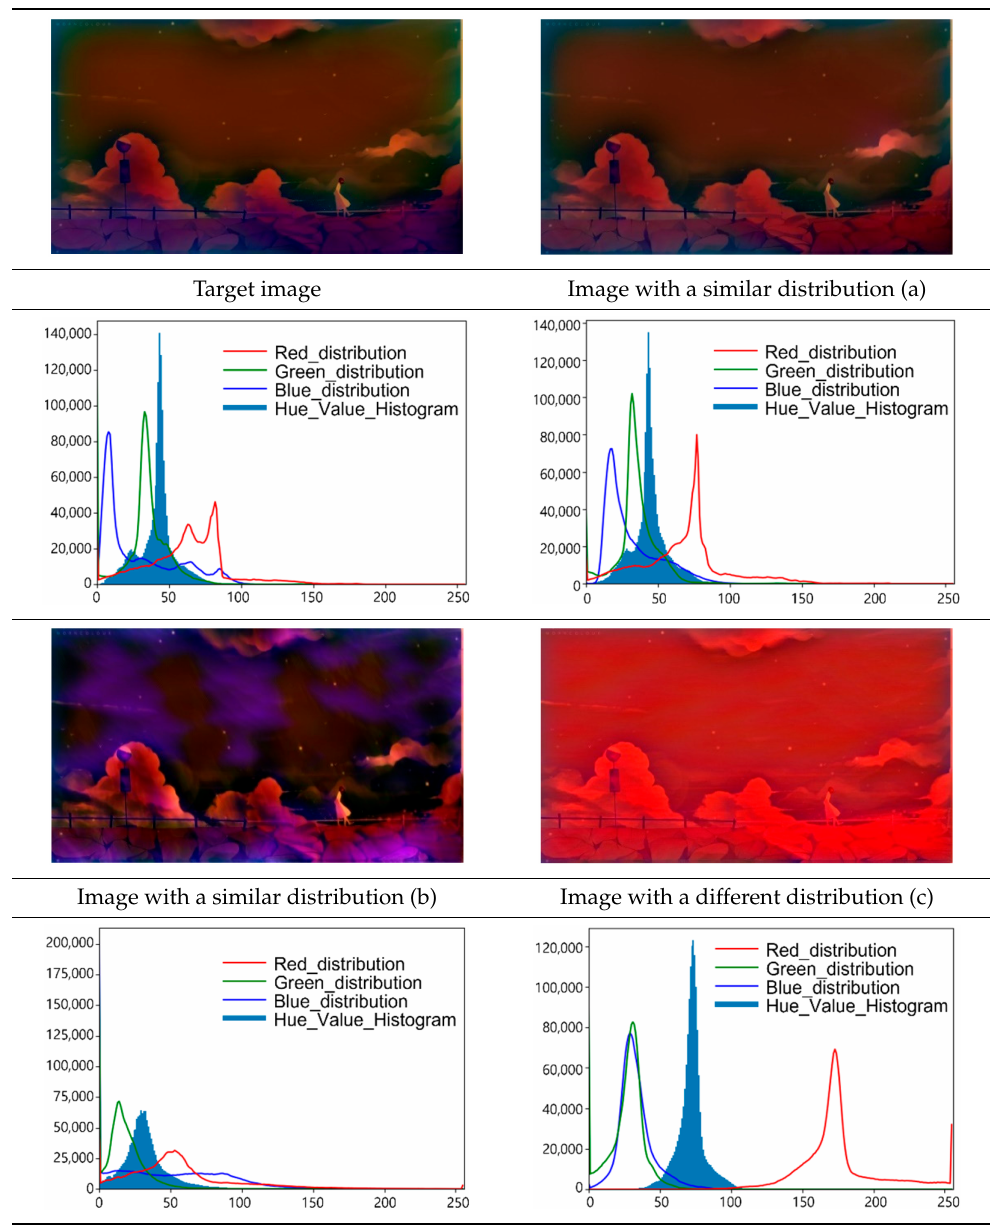
Table 6. Results of histogram graph according to RGB distribution, hue, and